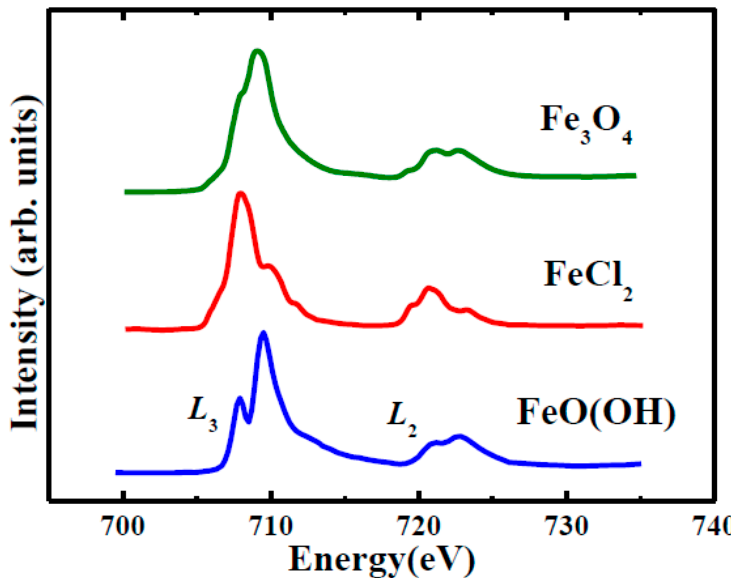
Figure B1. Reference iron L 2,3 -edge x-ray absorption spectra for ferric (FeO(OH); blue), ferrous (FeCl 2 ; red) and magnetite (Fe 3 O 4 ; green) iron phases.